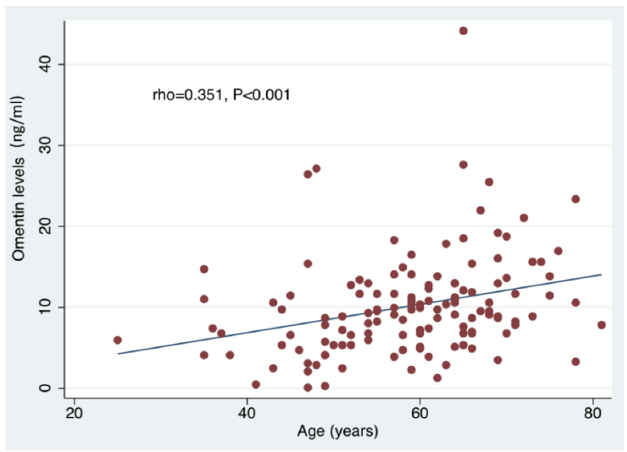
Figure 1. Spearman’s rank–order correlation depicts a significant correlation between age and circulating omentin levels (ng/ml).